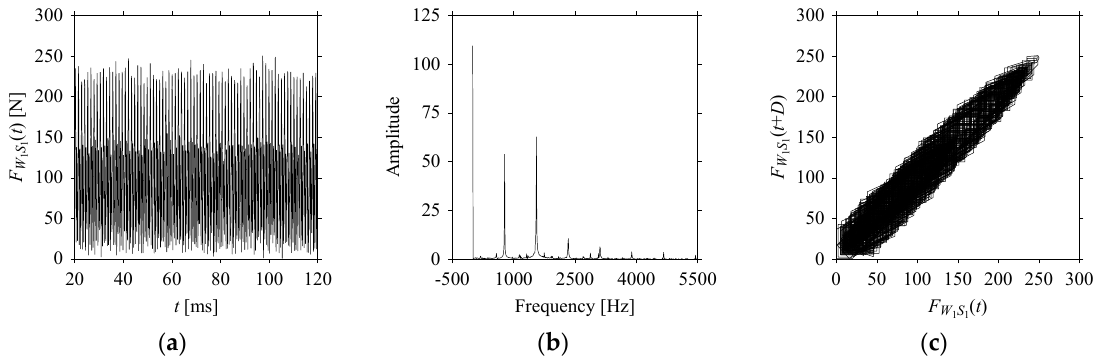
Figure 9. F W in the form of: ( a ) time series, ( b ) fast Fourier Transformation (FFT), and ( c ) delay map ( d = 1). 1 S 1